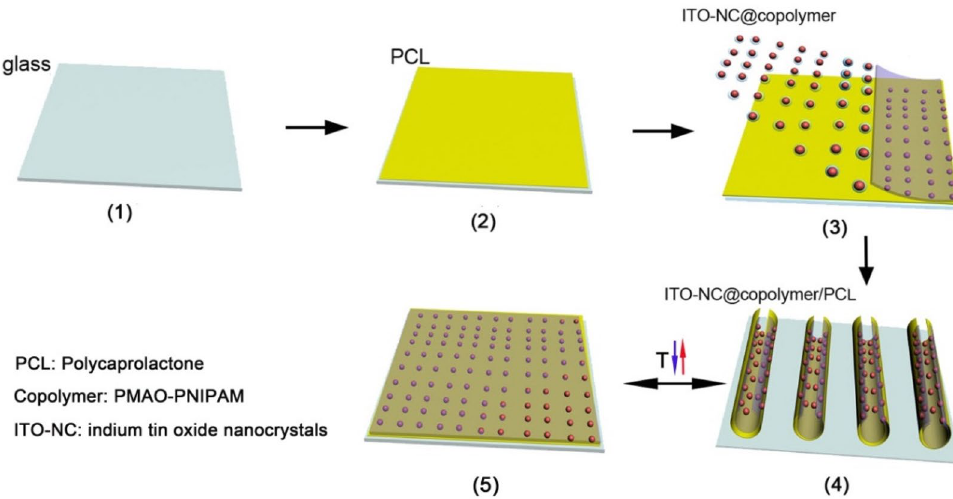
Figure 1. Schematic illustration of the procedure for demonstrating ITO-NC@copolymer/PCL (INCP) film, which exhibits thermo/photo-responsive properties changing with